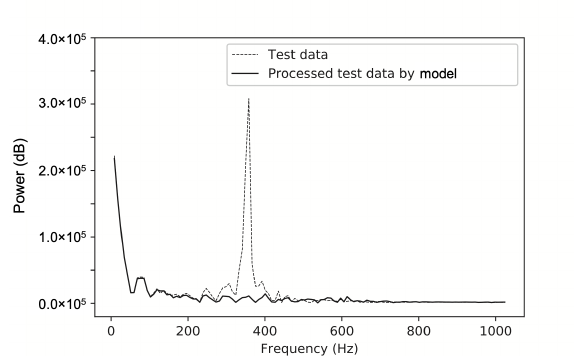
Figure 14. Test data processing and comparison by FFT (axial force).